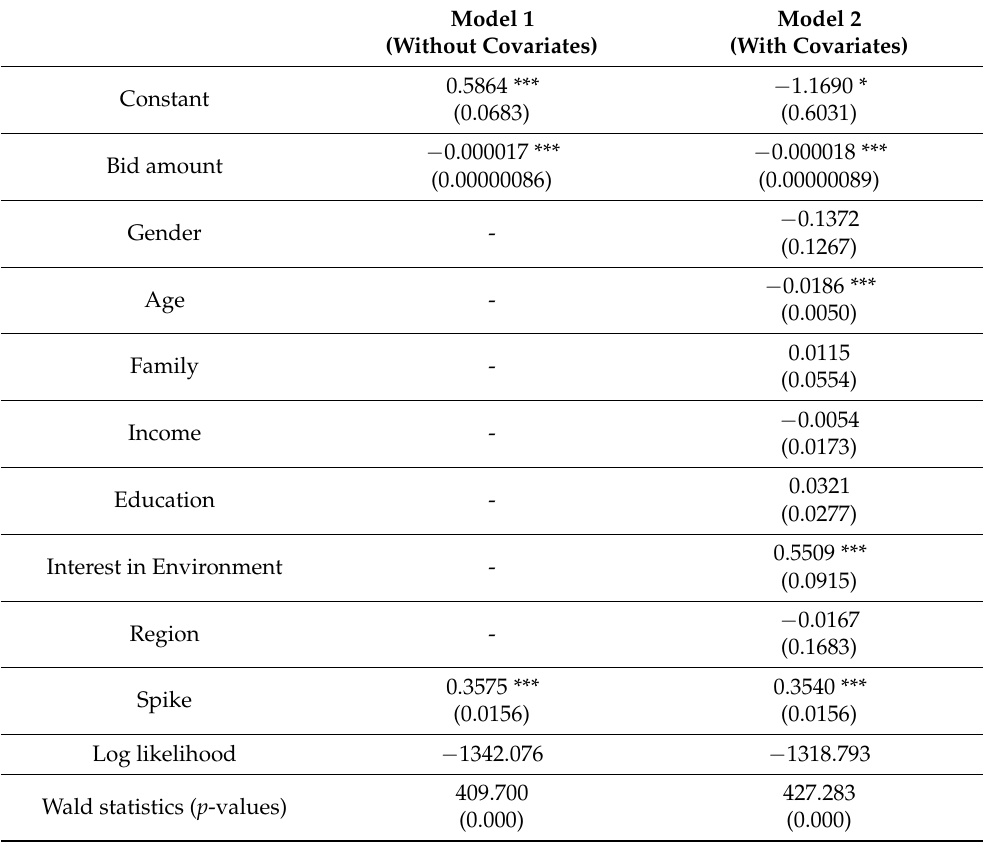
Table 4. Estimation results of the DBDC spike models (without and with